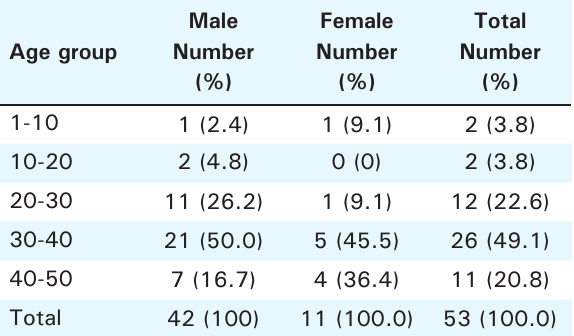
table 1. Distribution of patients by Age and Gender